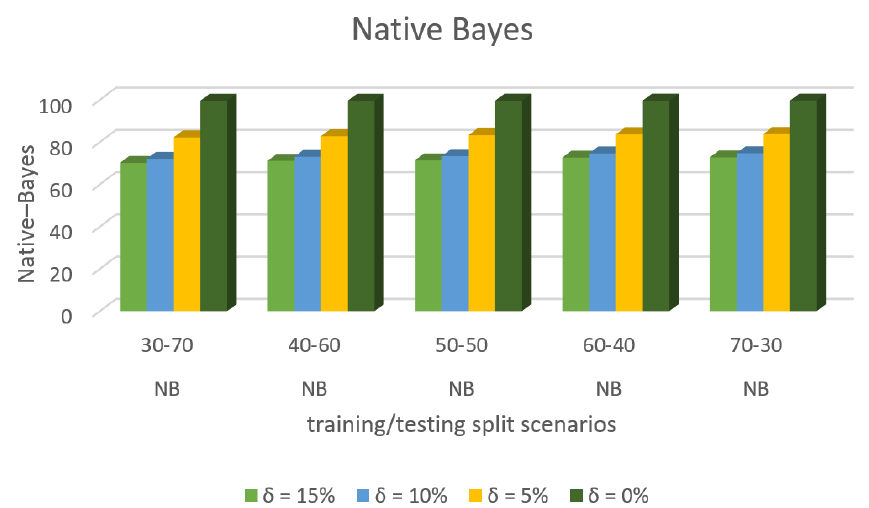
Figure 13. Accuracy Prediction for Dataset 2 using Native–Bayes Algorithm.